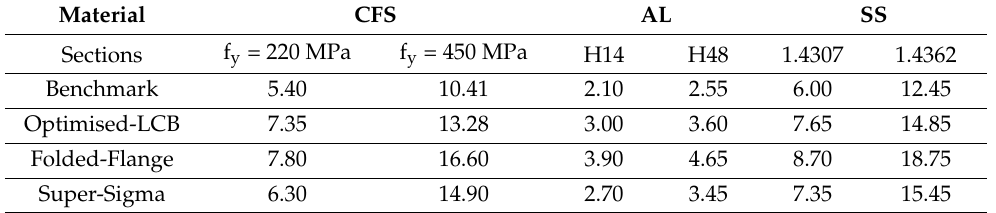
Table 7. Bending moment capacity for single sections.